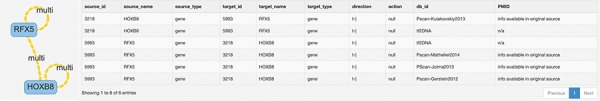
Multiple interactions. When multiple interactions between two entities are present in the same or another database, they are represented in the RING as a multi edge colored in yellow. To better understand the overall meaning of such edges, it is possible to click on them to retrieve a detailed table, displayed below the network, which reports all the details on the interaction of interest. This annotation becomes particularly important when different databases report different interaction directions; e.g. a TF may be reported as enhancer and silencer of the same target in different DBs.